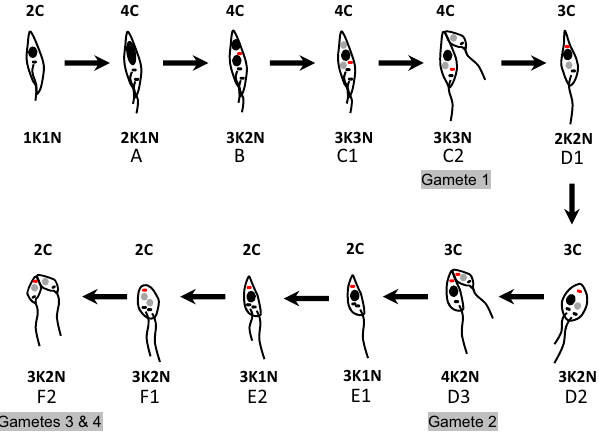
Fig. 7 Model of meiosis based on observed intermediates. Nuclei are shown in black (4C or 2C) or grey (1C). Kinetoplasts associated with a fl agellum are shown in black, while extra kinetoplasts not associated with a fl agellum are shown in red. For clarity, fl agella are drawn as separate lines, though two distinct fl agella were not always evident in imaged cells. The total DNA content of each trypanosome is indicated above the cell, while the relative numbers of kinetoplasts (K) and nuclei (N) are shown below, but note that the numbers of K varied in stages B – F2 (Supplementary Table 3). Intermediates A – F are described in the